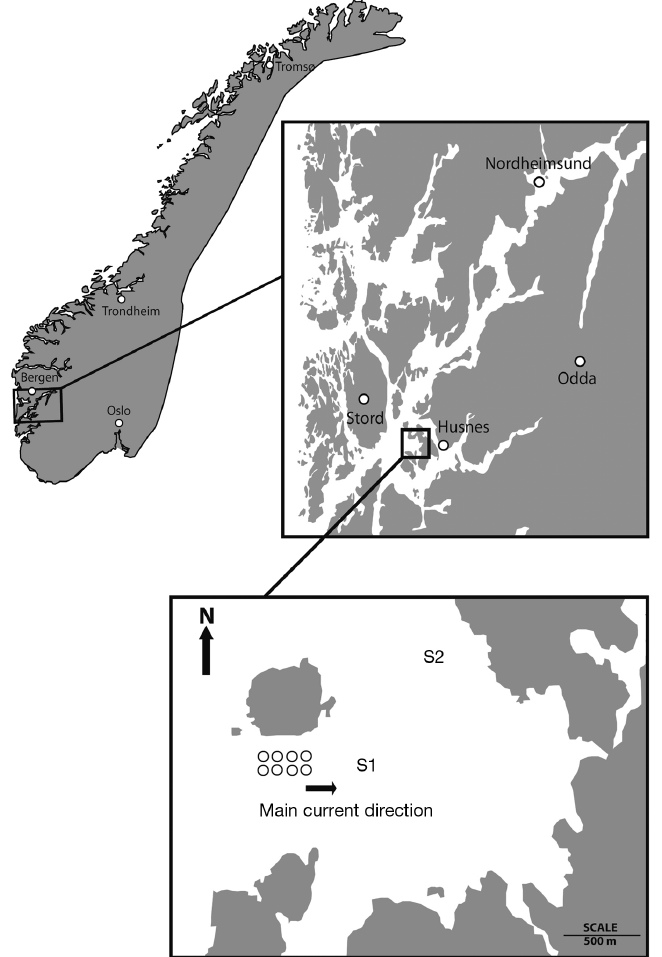
Fig. 1. Hardanger Fjord in Norway. The insets highlight the region where the studied salmon farm was located. S1: farming location; S2: reference location; s : fish net pen